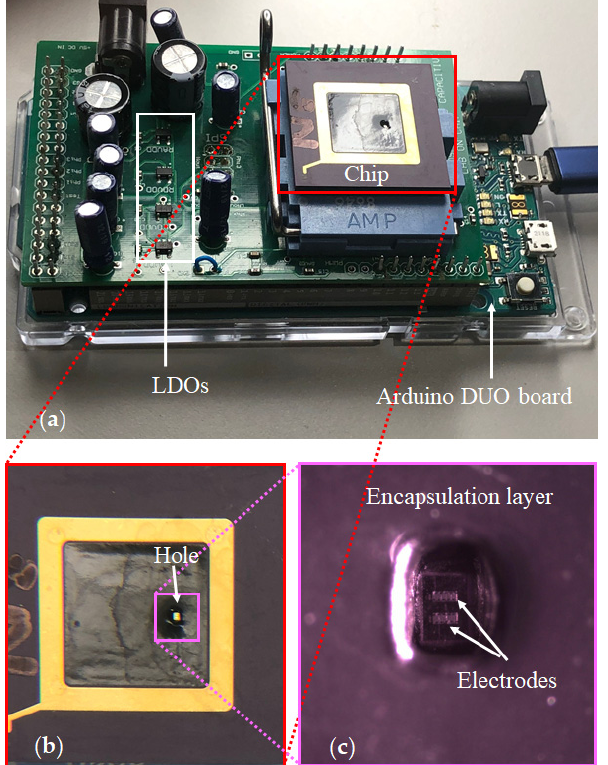
Figure 9. The testbench hardware: ( a ) An Arduino DUE microcontroller board together with a custom-made electronic board holding the chip; ( b ) The chip; ( c ) The microscopic image of the two electrodes and the surrounding encapsulation layer with a hole for the non-passivated sensing electrodes.